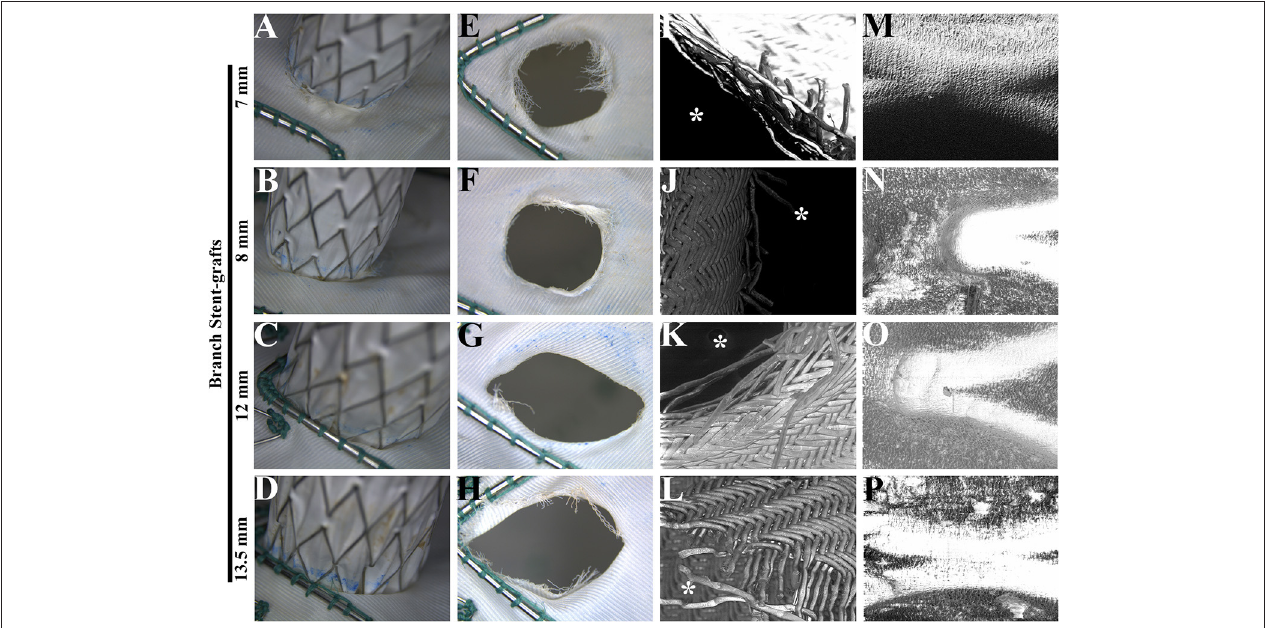
FIGURE 4 | Morphological analysis of main and branch stent grafts after a fatigue test. (A–D) The connections of main and branch stent grafts were estimated by light microscopy. (E–H) The fabrics around the fenestrations on the main stent grafts were estimated by light microscopy. (I–L) The fabrics around the fenestrations on the main stent grafts were estimated by scanning electron microscopy. The magnification was 100 × . *, the inner side of fenestrations. (M–P) The membrane and metal structures of branch stent grafts were examined by scanning electron microscopy. The magnification was 100 ×